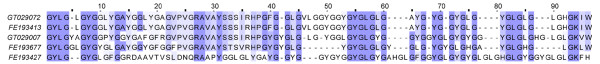
Sequence alignment of Glycine-rich peptides. GT02s represent the dbEST accession numbers for Yunnan-sourced Lychas mucronatus cDNA library. FE19s represent the dbEST accession numbers for Hainan-sourced Lychas mucronatus cDNA library.